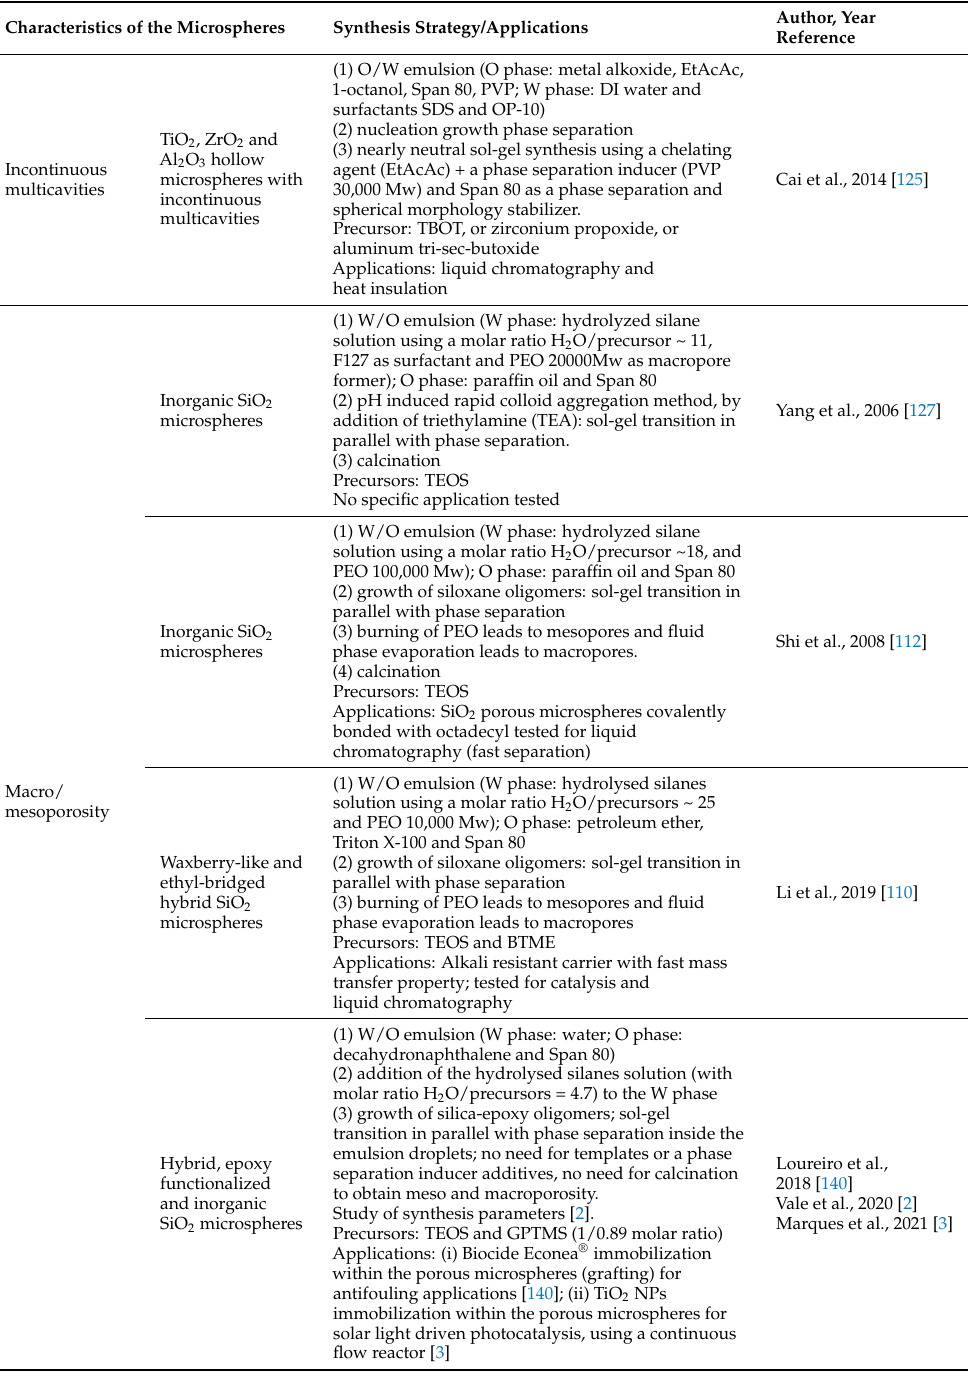
Table 5. Compilation of specific examples of macroporous microspheres and their synthesis strategies based on the emulsion method combined with sol-gel transition and phase